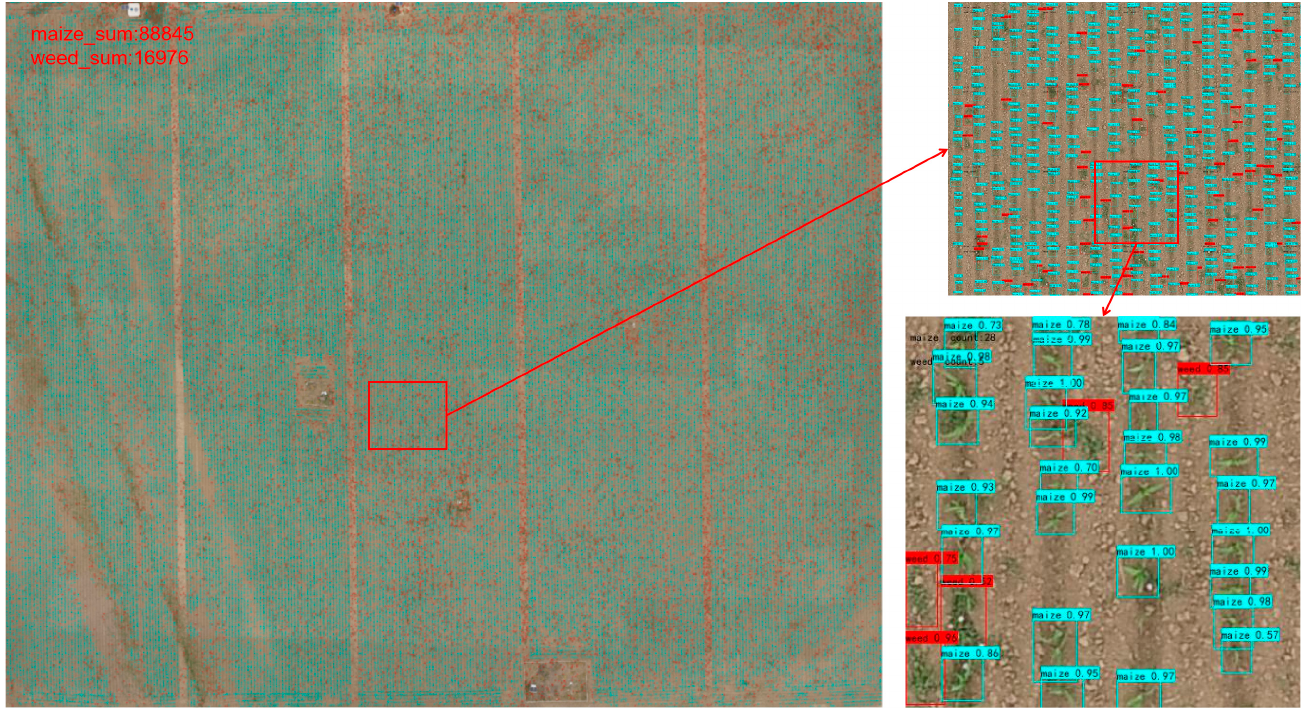
Figure 11. Distribution map of maize and